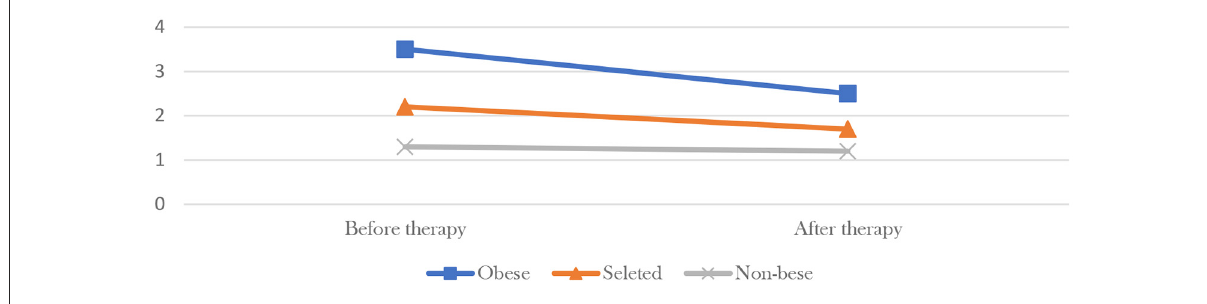
FIGURE5 HOMA-IR change of selected participants in Aichi Prefecture pilot base.